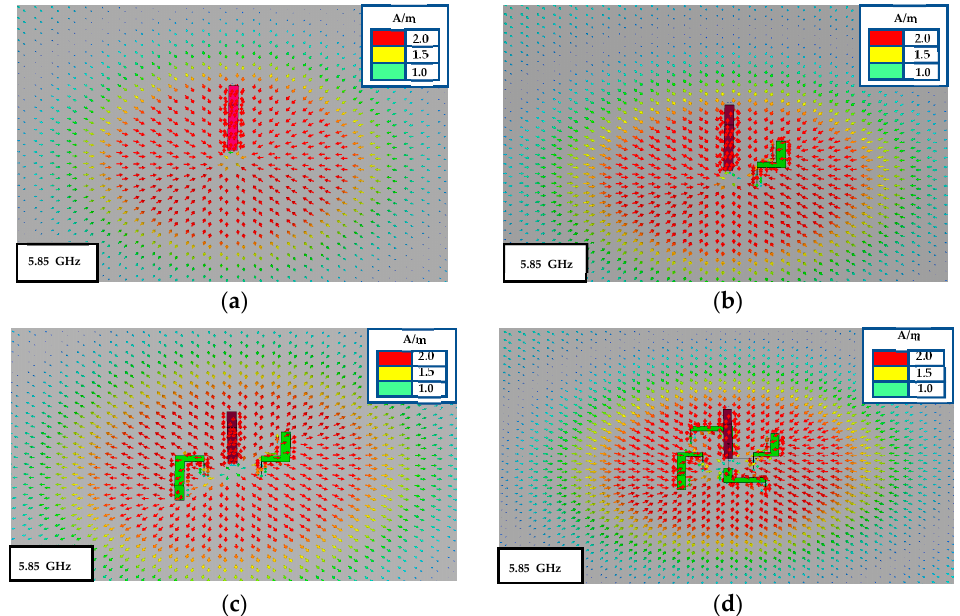
Figure 2. Surface current distribution obtained from ( a ) Monopole-only WAVE antenna; ( b ) Single; ( c ) Dual; and ( d ) Quadruple closed-loop devices with monopole WAVE antenna.